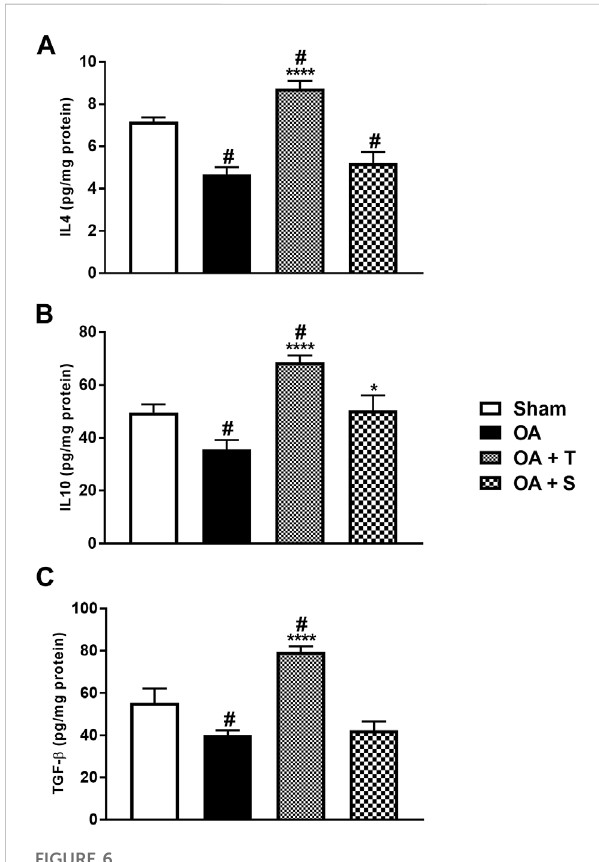
FIGURE 6 Anti-in fl ammatory cytokines. (A) IL4; (B) IL10; (C) TGF- β . Abbreviations: IL, interleukin; OA, osteoarthritis; TGF, transforming growth factor. Data are presented as mean ± SEM, in which: # p